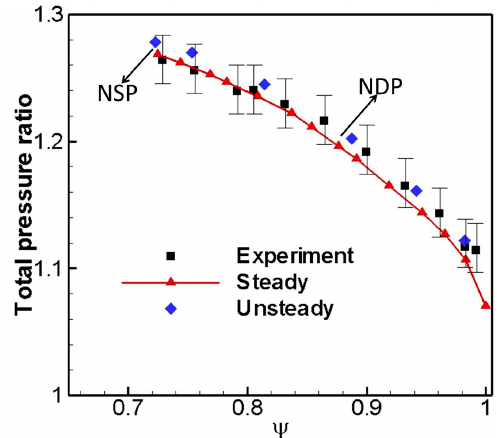
Figure 4. The comparison of predicted and experimental total pressure ratio curves at design speed.